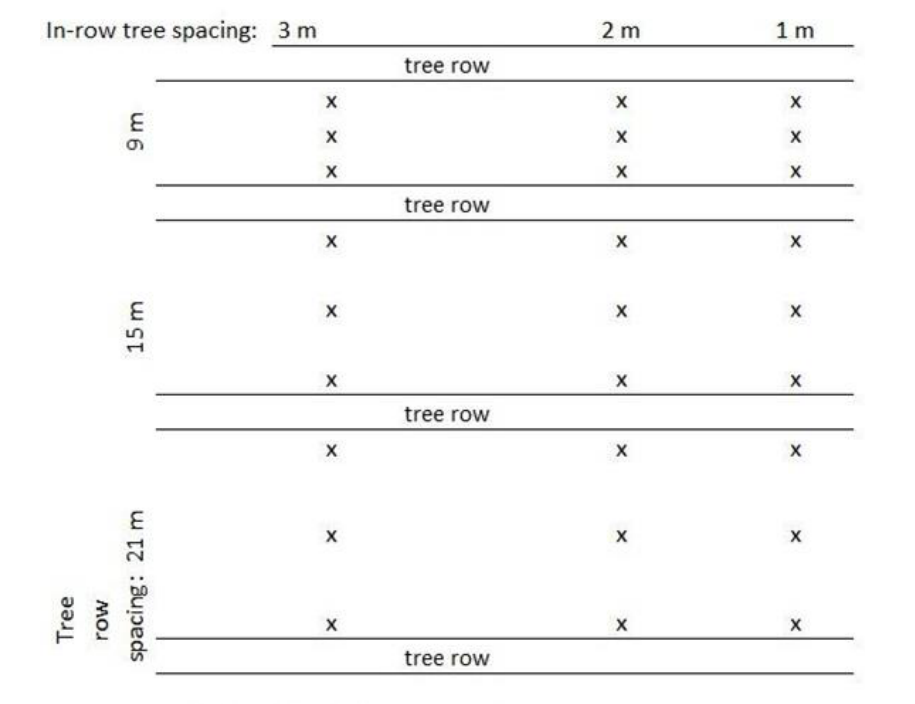
Figure 7. Schematic map of the experiment. Replications are not shown. “x” marks the sampling points of the intercrop.